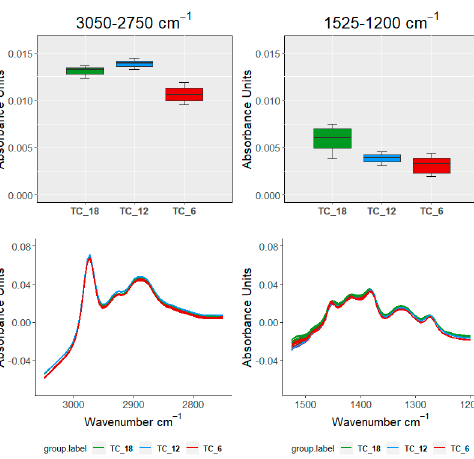
Figure 8. Plots of two of the four significant areas of the Traditional Chestnut (TC) curves. In the first row, vectorial analysis by means of boxplots. In the second row, FDA through curves in the studied interval. The wine spirit sample is divided into three groups depending on the ageing time (18, 12, and 6 months of ageing).